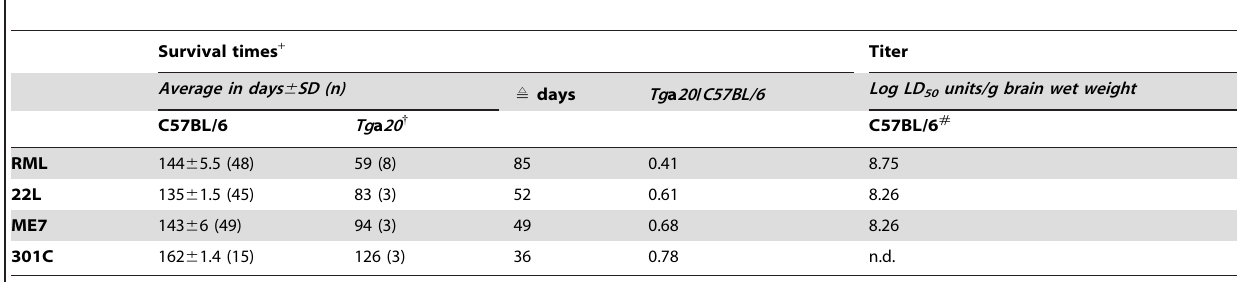
Table 3. Characteristic parameters of various prion strains in C57BL/6 and Tg a 20 mice.